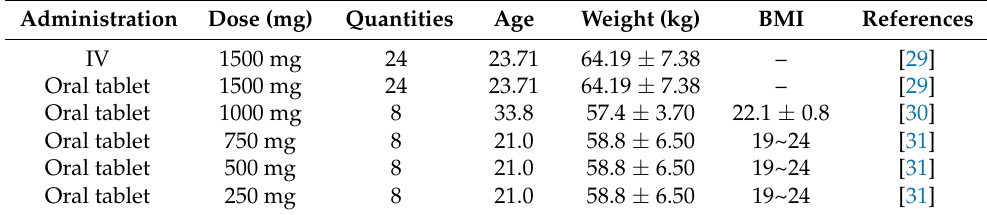
Table 2. In vivo pharmacokinetic literature information summary for